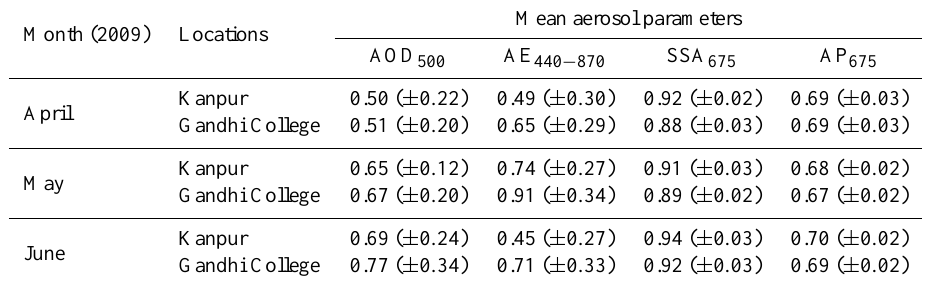
Table 1. Mean value ( ± standard deviation) of aerosol parameters at different stations over IGB region during